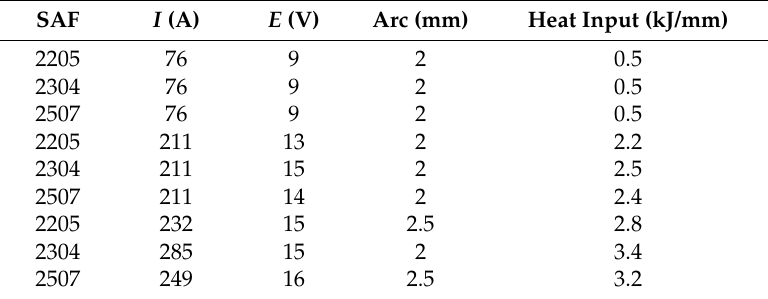
Table 2. Parameters obtained by the Tungsten Inert Gas (TIG) welding process. SAF I (A) E (V) Arc (mm) Heat Input (kJ/mm)